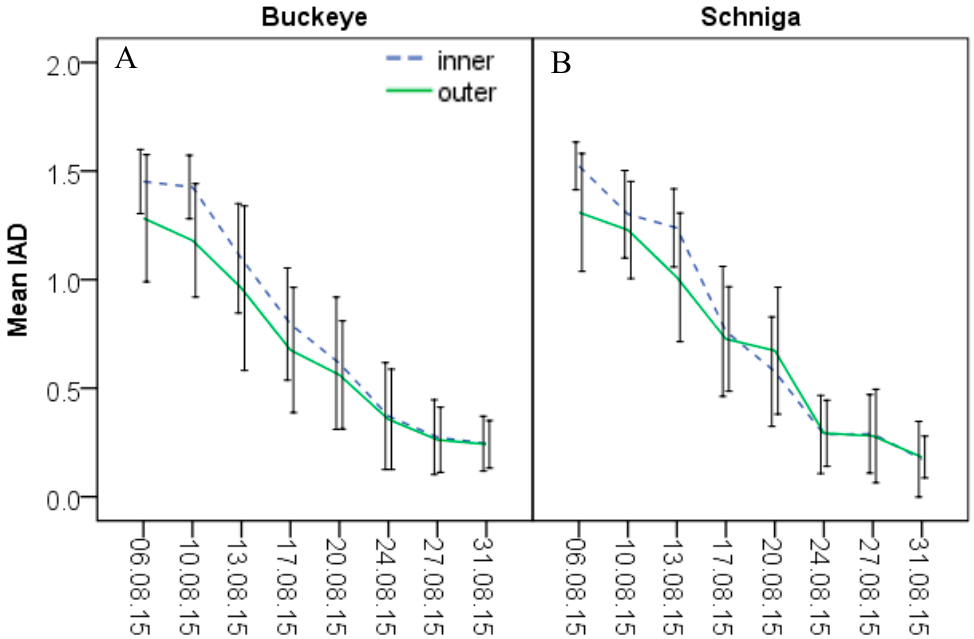
Figure 1. Changes (mean and standard deviation) of index of relative chlorophyll content (IAD) in the inner and outer canopy fruit during maturation (6 August to 31 August) in 2015 for ( A ) cv. ‘Gala Buckeye’ and ( B ) cv. ‘Gala Schniga’.